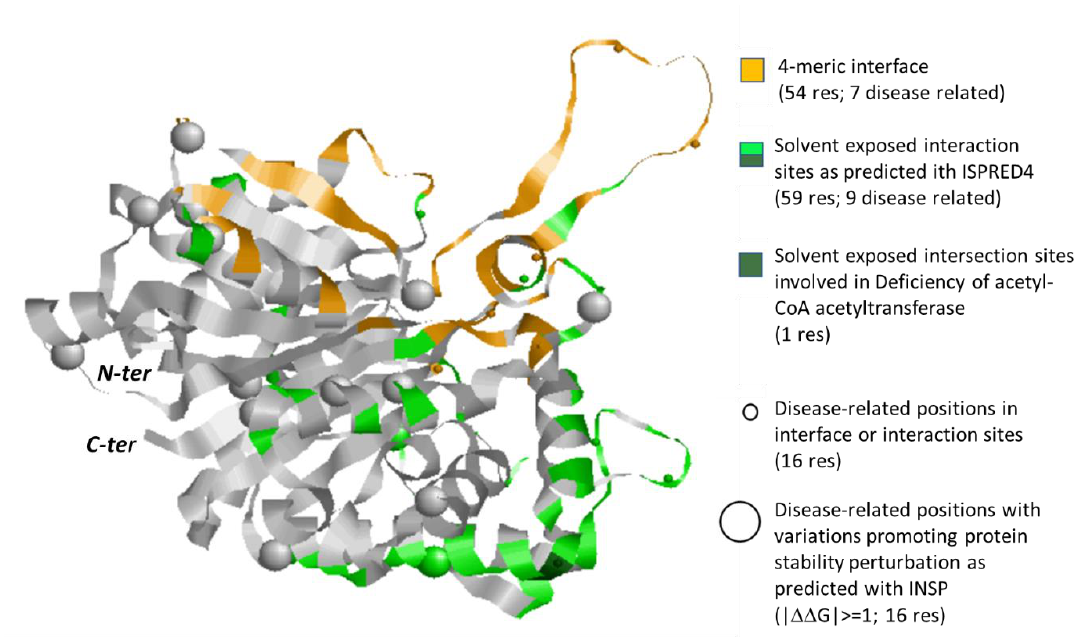
Figure 7. Monomeric subunit of human ACAT2 protein (PDB code: 1WL4.A). Interaction surface in the tetramer as derived from the crystallographic coordinates is in orange. Interaction sites out the tetrameric interface, as predicted with ISPRED4 are in green. Positions in these regions carrying disease related variations (Table S4 (Supplementary Materials)) are highlighted with small spheres. Big spheres highlight positions in the protein carrying disease related variations (Table S4, for details) and promoting a large variance of folding free energy, as predicted with INPS [26]. Grey color: the background protein backbone.